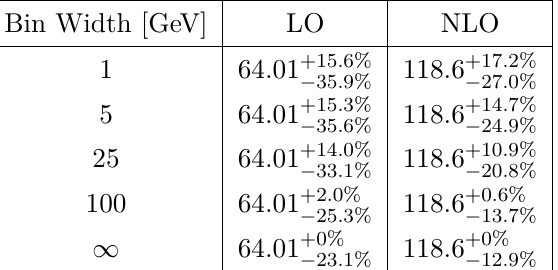
Table 2. Inclusive OS results for the LO and NLO gg → ZH cross sections and relative top-mass- scheme uncertainties. The uncertainties are computed according to refs. [54,